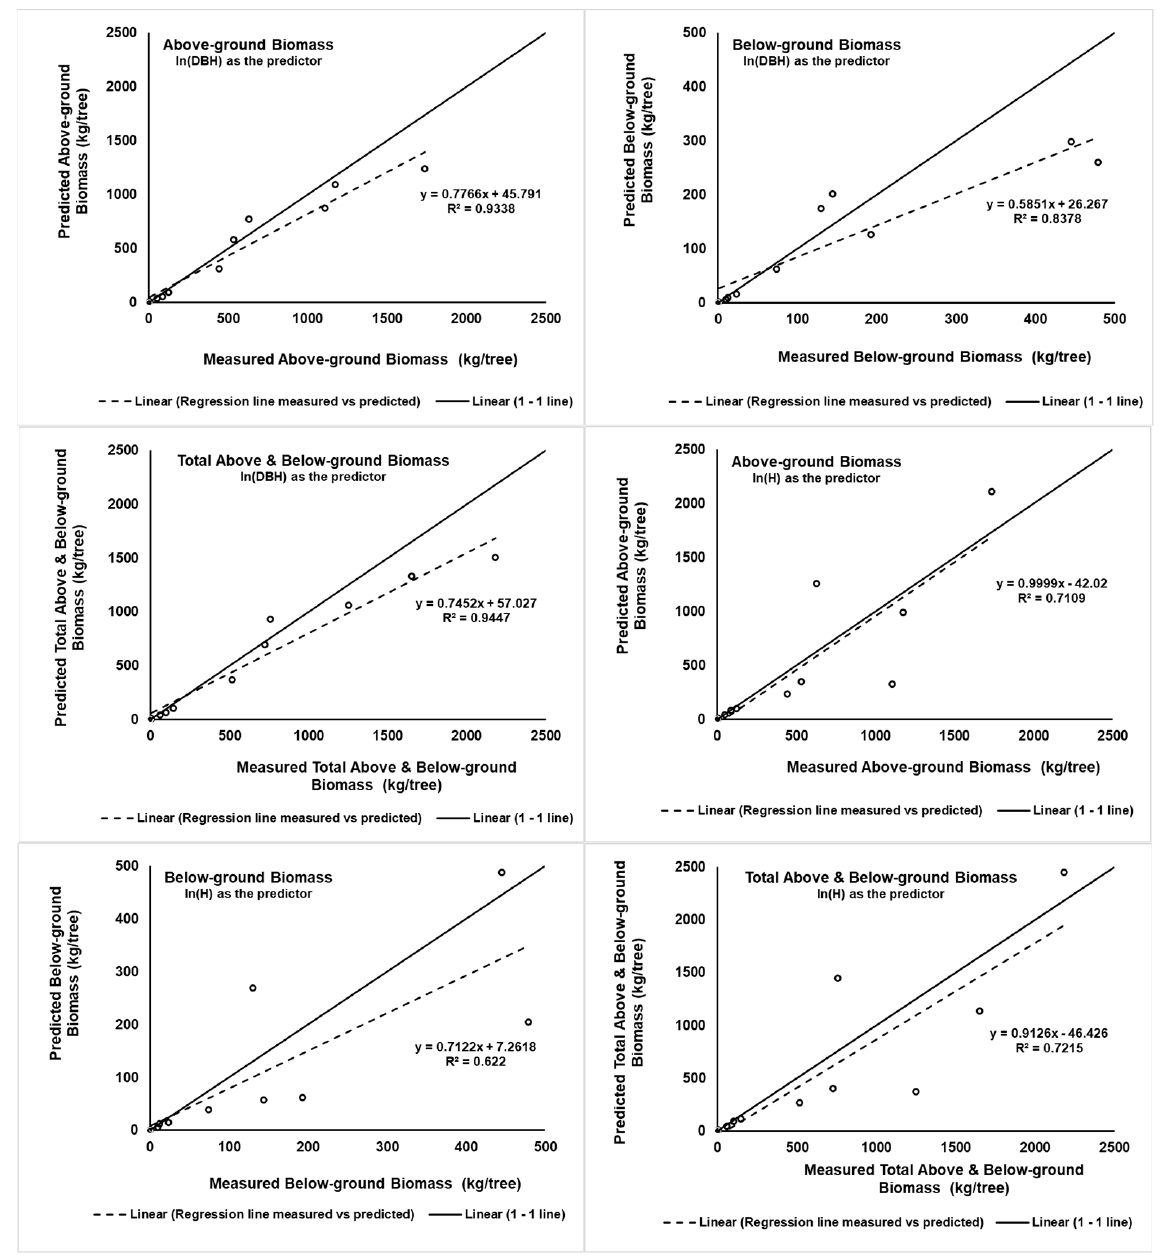
Figure 2. Distribution of the measured vs. predicted biomass on the 1–1 line.